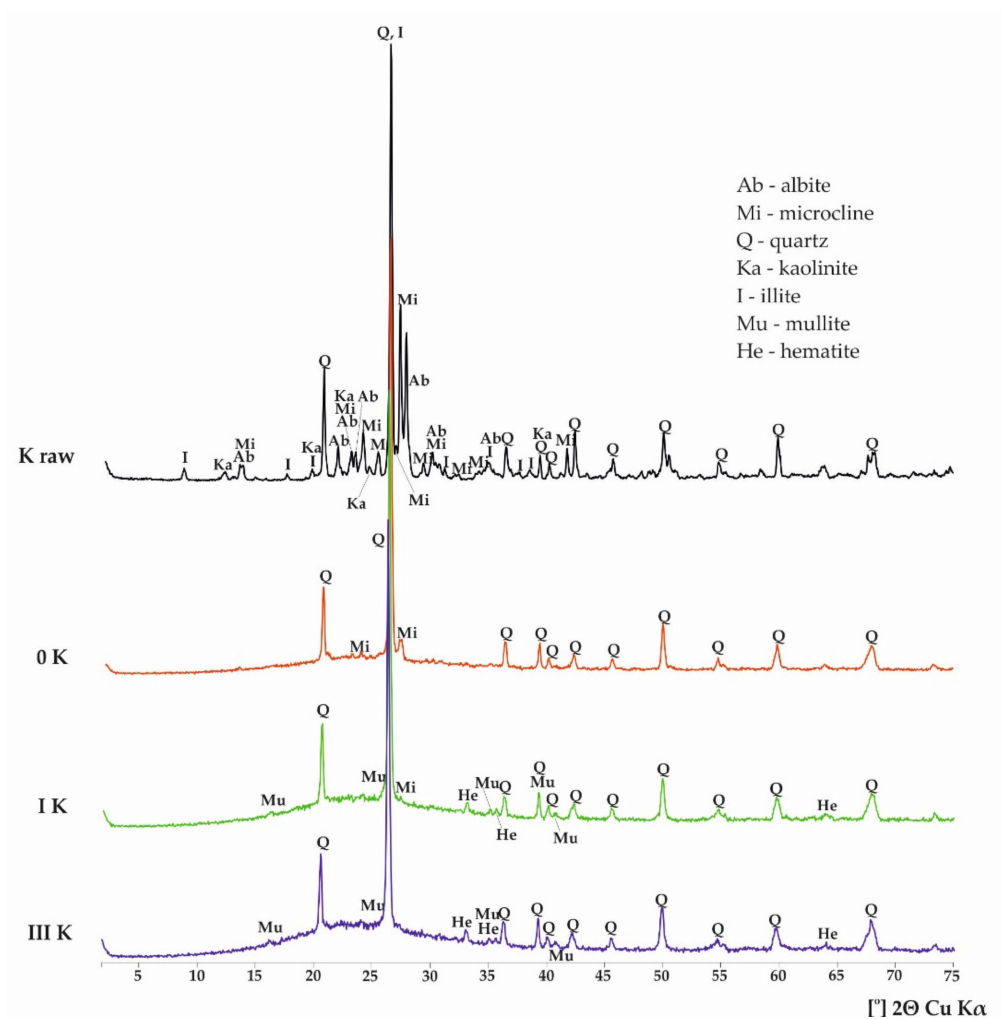
Figure 3. XRD patterns of potassium feldspar-quartz samples in a raw state / unfired (K raw) and the samples after firing: without synthetic pigments addition (0 K), as well as doped with 1.5% Fe 2 O 3 (I K), and with 1.5% Fe 2 O 3 + 0.5% TiO 2 (III